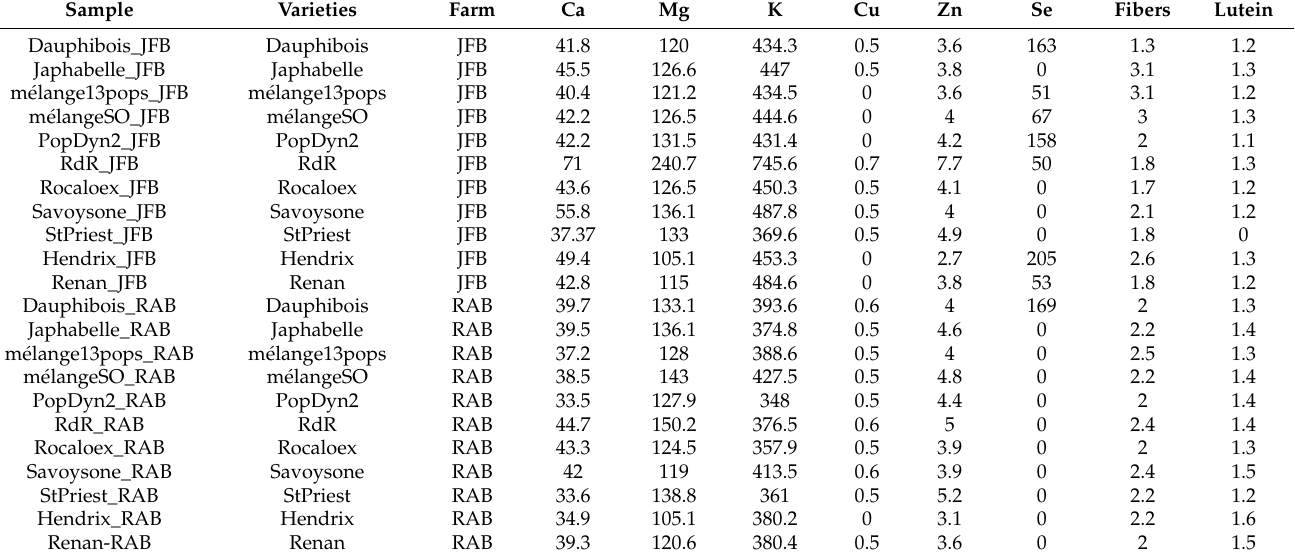
Table A1. Content of Lutein, Selenium (Se, µ g/kg), Copper (Cu, mg/100 g), Calcium (Ca, mg/100 g), Magnesium (Mg, mg/100 g), Potassium (K, mg/100 g), Zinc (Zn, mg/100 g)) and Fiber (g/100 g) of 11 varieties grown in two environments.